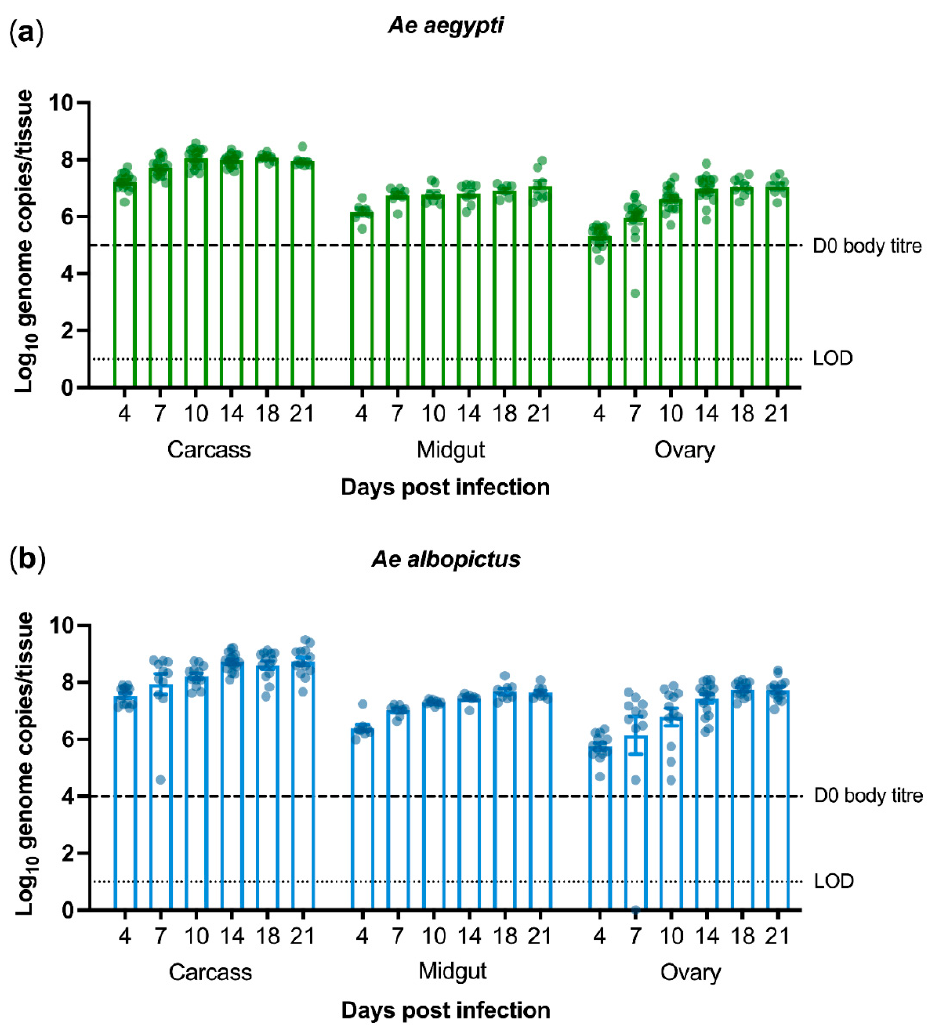
Figure 1. Palm Creek virus titres in intrathoracically injected Aedes aegypti ( a ) and Ae. albopictus ( b ) mosquitoes as quantified by qRT-PCR. Each data point denotes an individual mosquito from two experimental replicates. At each timepoint, carcasses and ovaries were collected from 16 individuals, whereas midguts were collected from eight individuals. Bars depicting means, standard errors, limit of detection (LOD), and virus titre of whole injected mosquitoes on the day of infection (D0) are shown.